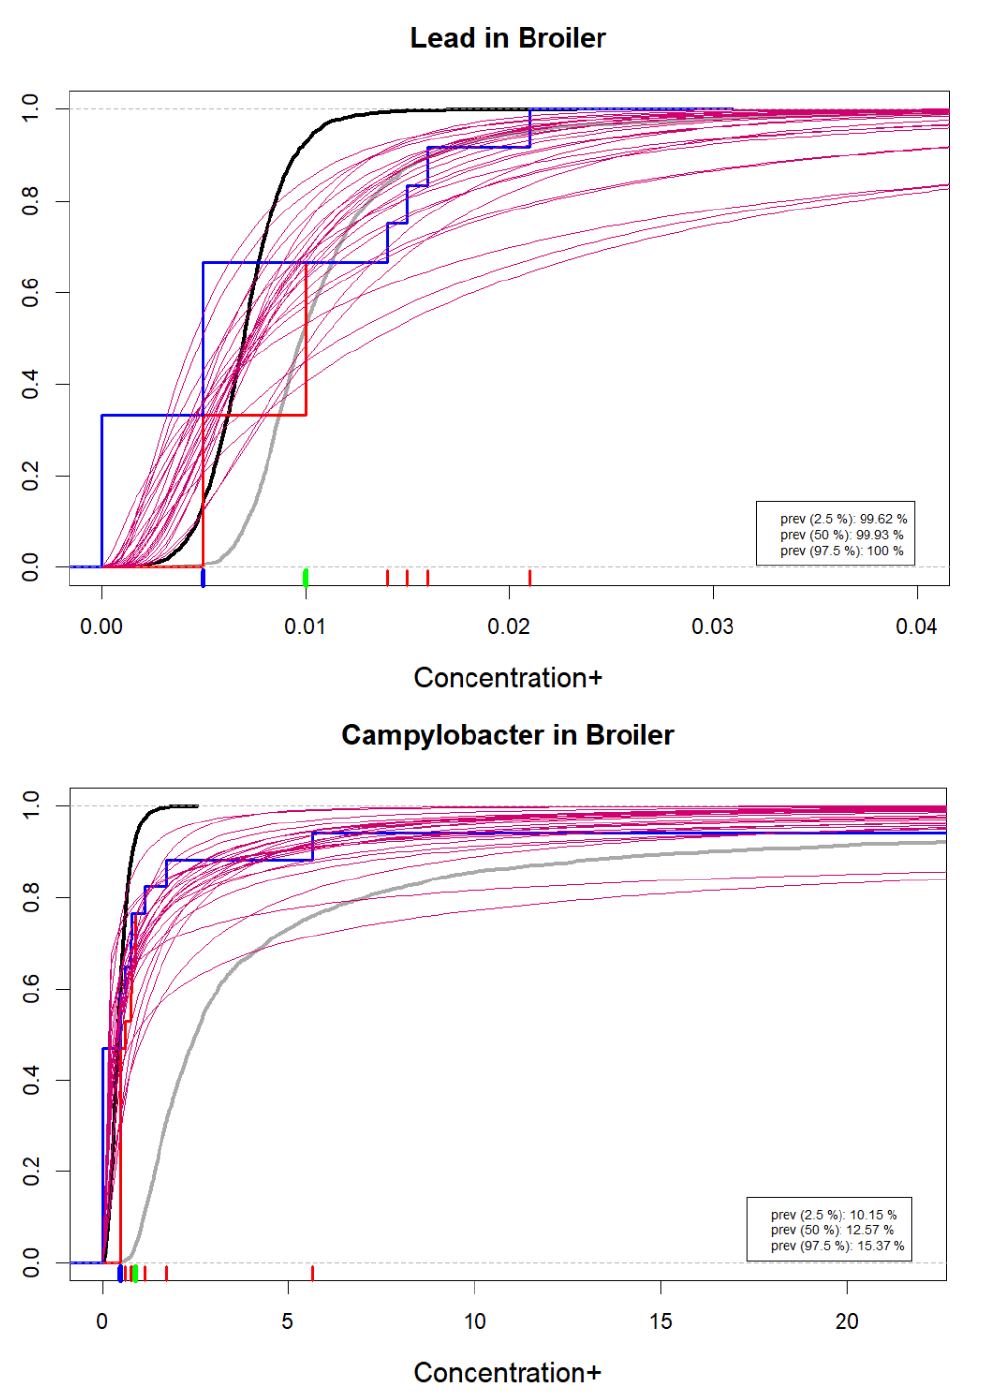
Figure 2. Example cumulative distributions of chemical ( top ) and microbiological ( bottom ) pos- itive concentrations in the servings of the given food type. A sample of probable concentration distributions (magenta) and the uncertainty distributions for concentration mean (gray) and median (black). Observed data empirical cumulative distribution in blue/red with lowerbound/upperbound substitution of censored measurements is for comparison. Individual data points shown as red ticks, with green marks for values below LOQ and blue marks for values below LOD. Hazard prevalence estimate is given numerically. Numerical values on horizontal axis depend on the measurement unit used in the user’s data, e.g., mg/kg, µ g/kg, CFU/g or CFU/mL,